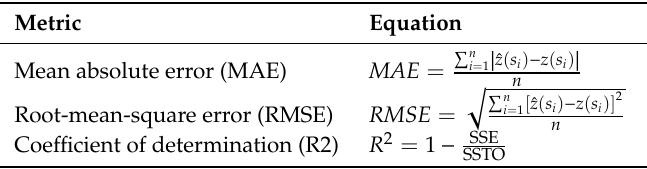
SSE: Error sum of squares. SSTO: total sum of squares.